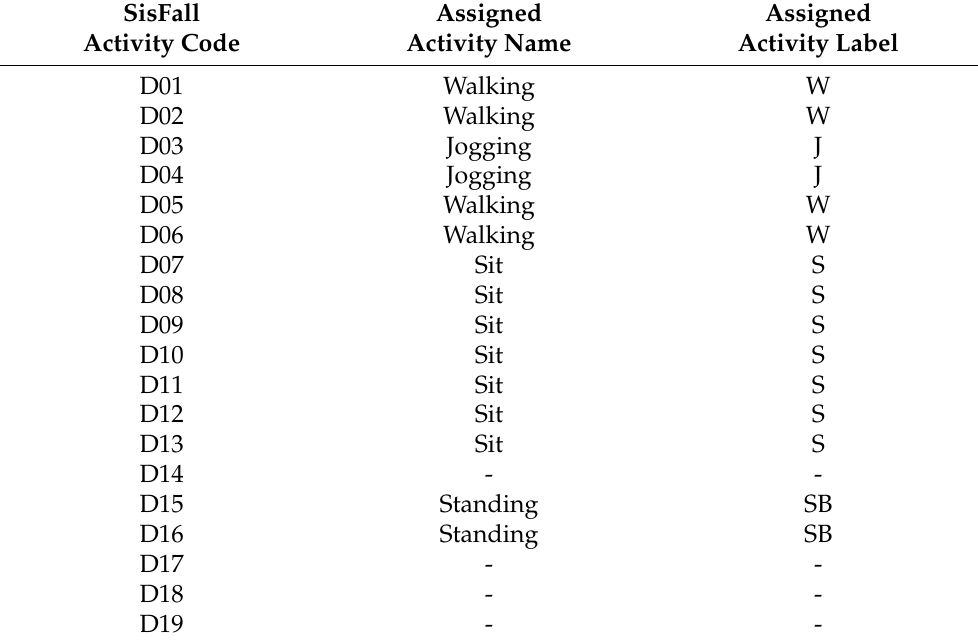
Table 1. Labeling used for Activities in the SisFall